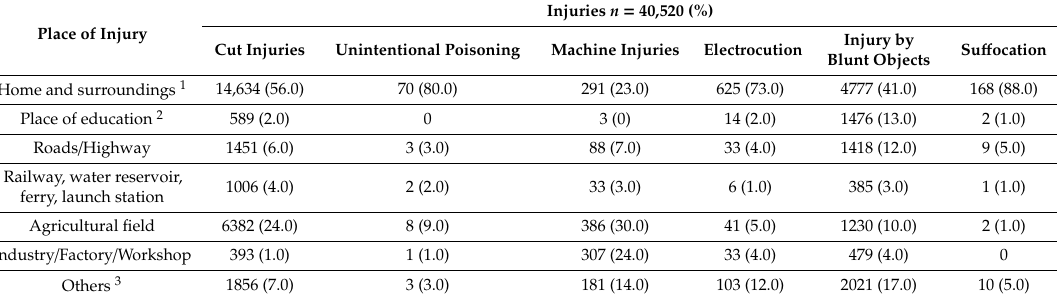
Table 2. Characteristics of non-fatal injuries by place of injury.